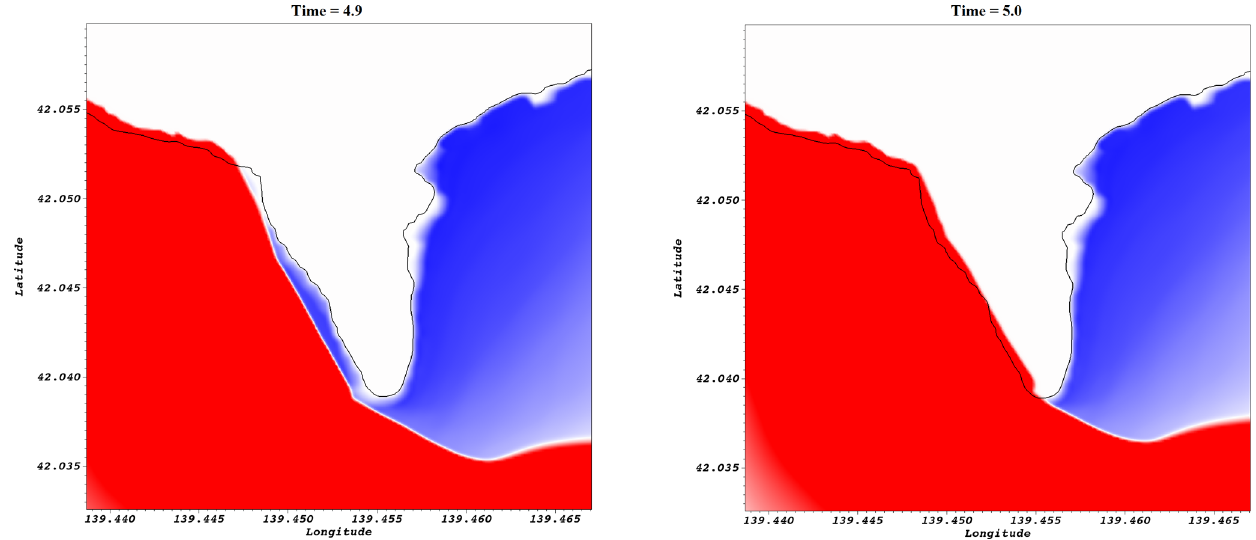
Figure 20. Arrival wave at Aonae peninsula coming from the west, snapshots of the wave at times 4.9 and 5.0min after tsunami generation.